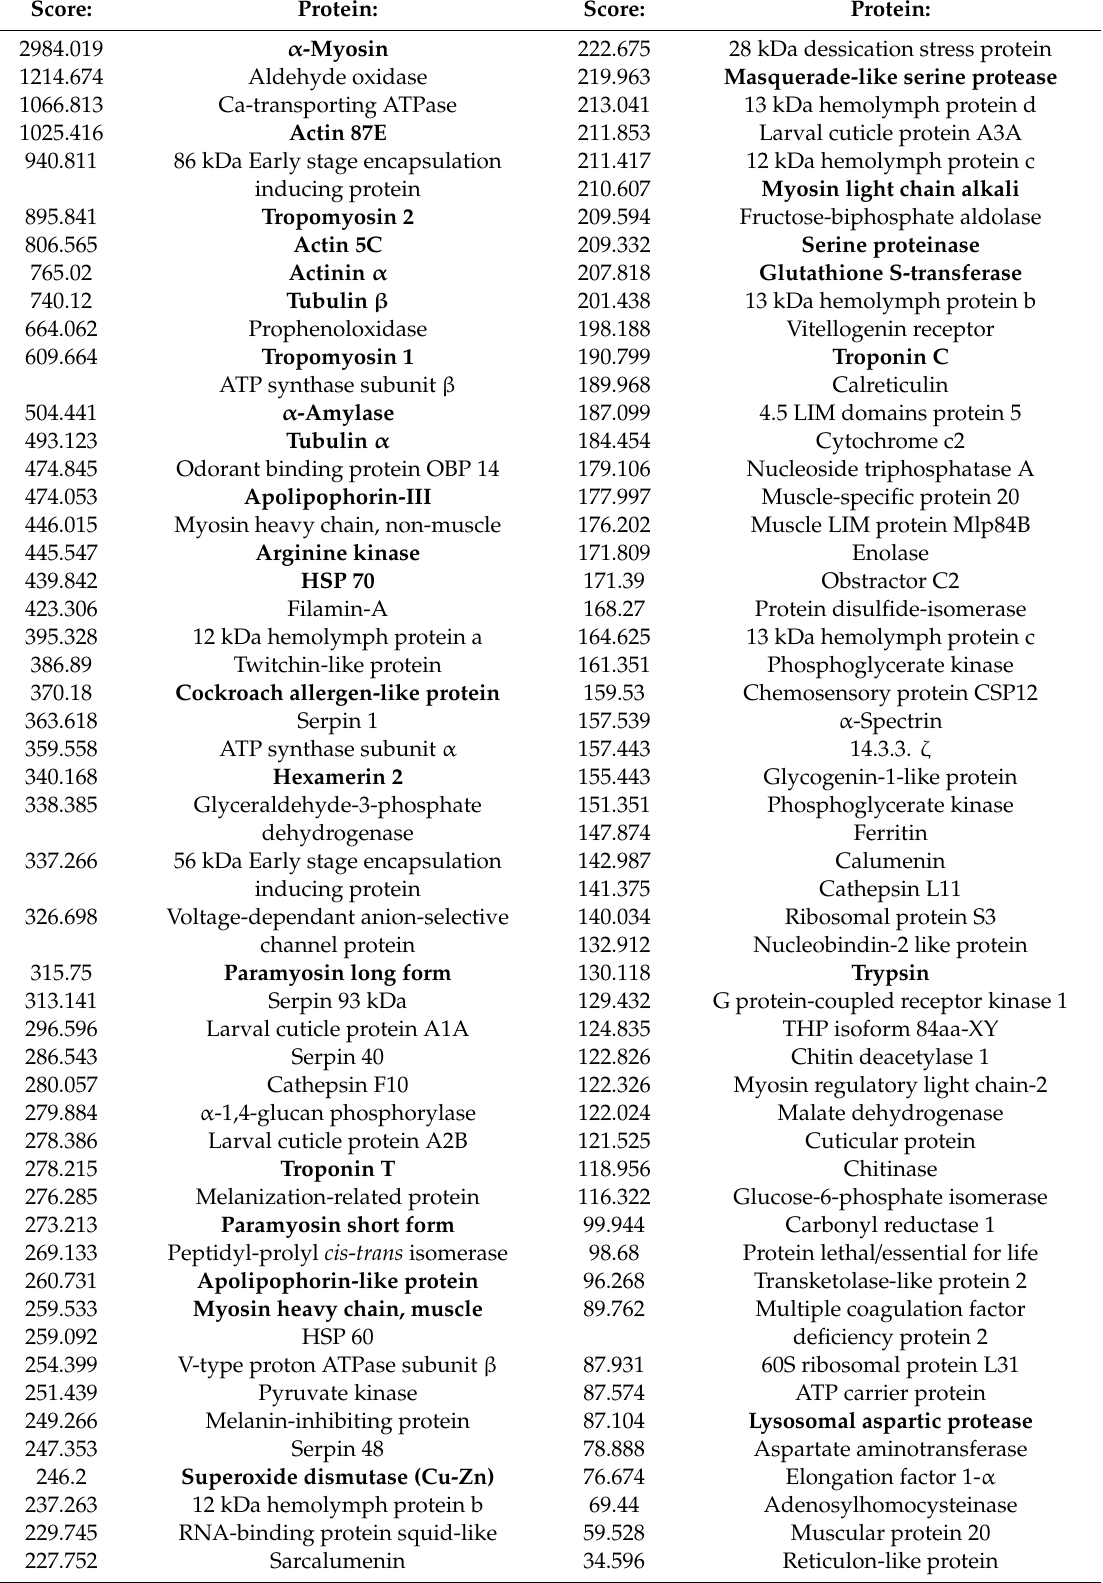
Table 1. List of proteins identified in the yellow mealworm ( Tenebrio molitor ) protein extract. Proteins are ranked by decreasing scores. Proteins already identified as IgE-binding allergens from arthropods are in